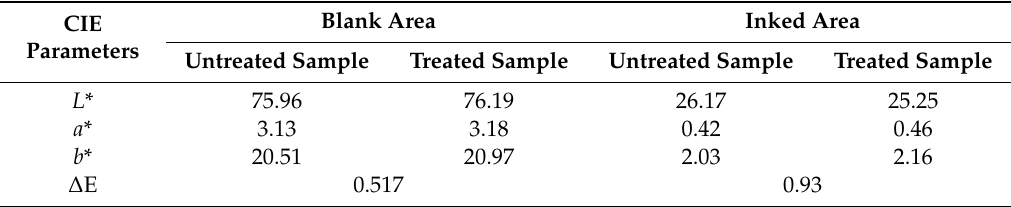
Figure 2. Water drops on the surfaces of the untreated (upper region of the dashed bright yellow line) and treated paper relics (lower region the dashed bright yellow line) ( a ) and the measured water contact angle (WCA) of the untreated ( b ) and treated ( c ) paper relics. Table 2. Color changes of untreated and treated paper-based relics.